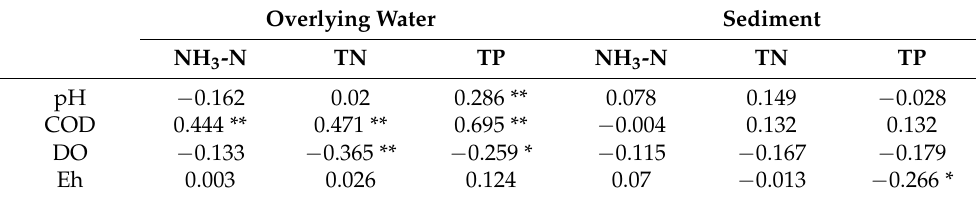
Table 2. Correlation between N, P, and other water quality parameters in overlying water and sediment. Overlying Water Sediment NH 3 -N